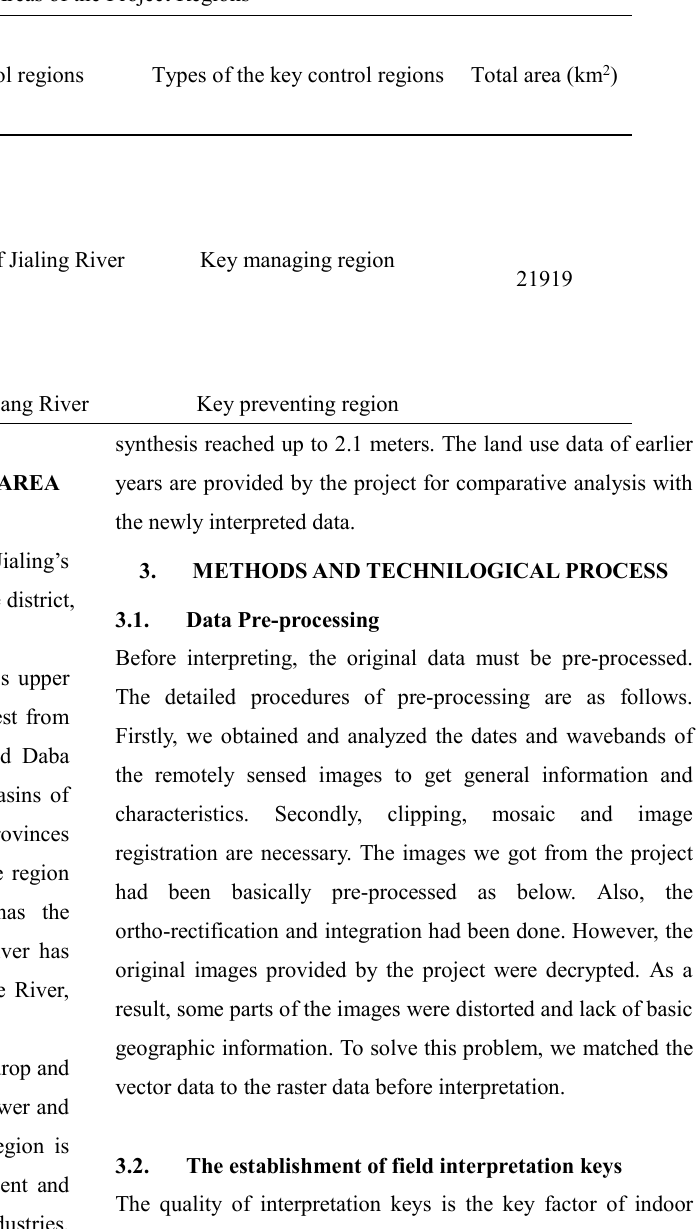
Table 1. Areas of the Project